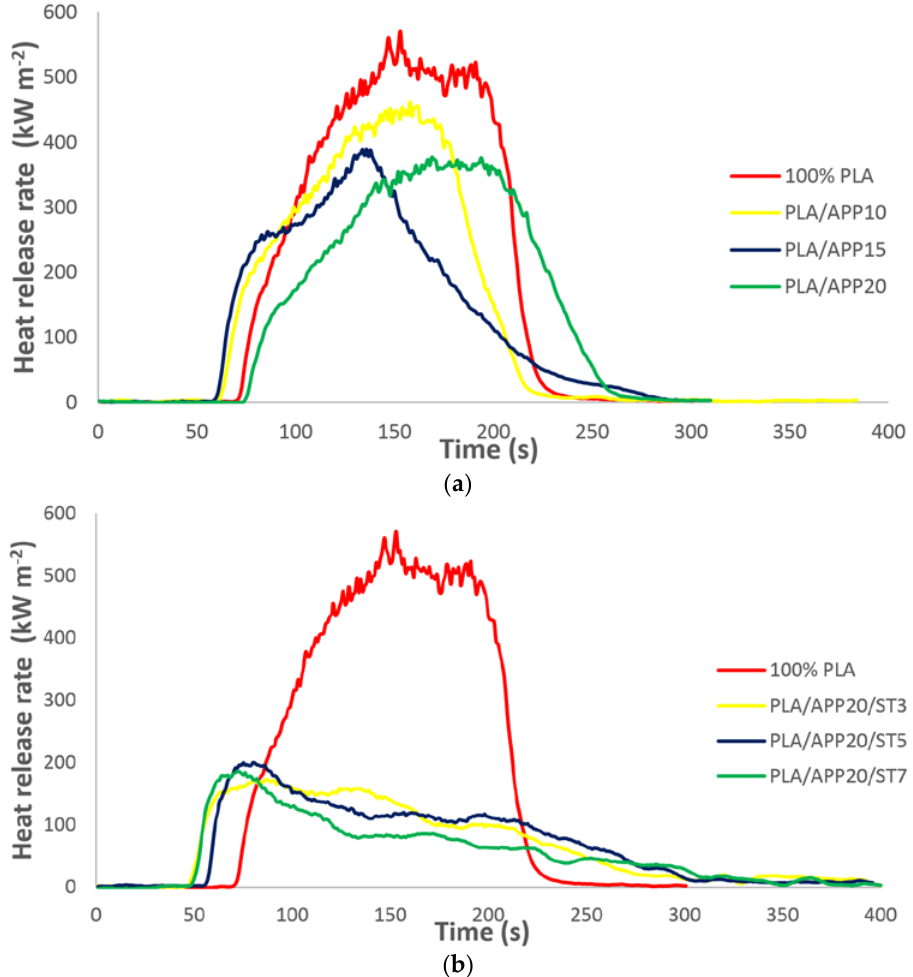
Figure 3. ( a ) Heat release rate curves of pure PLA and PLA/APP composites. ( b ) Heat release rate curves of pure PLA and PLA/APP/ST composites.